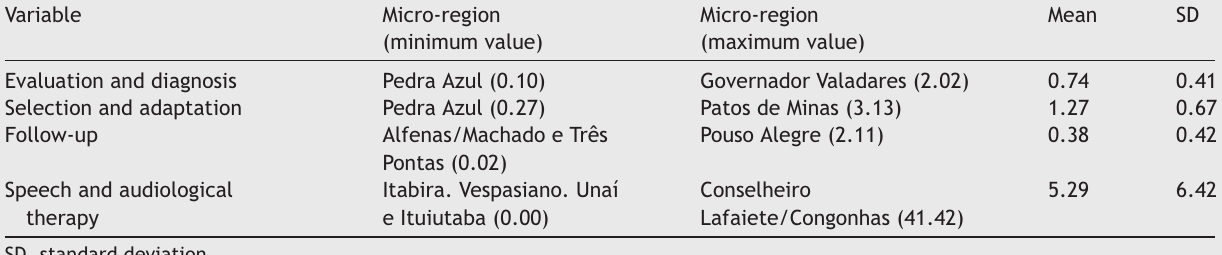
SD, standard deviation. Minimum, maximum, mean, and standard deviation values as a function of the absolute number of procedures performed in the state of Minas Gerais.